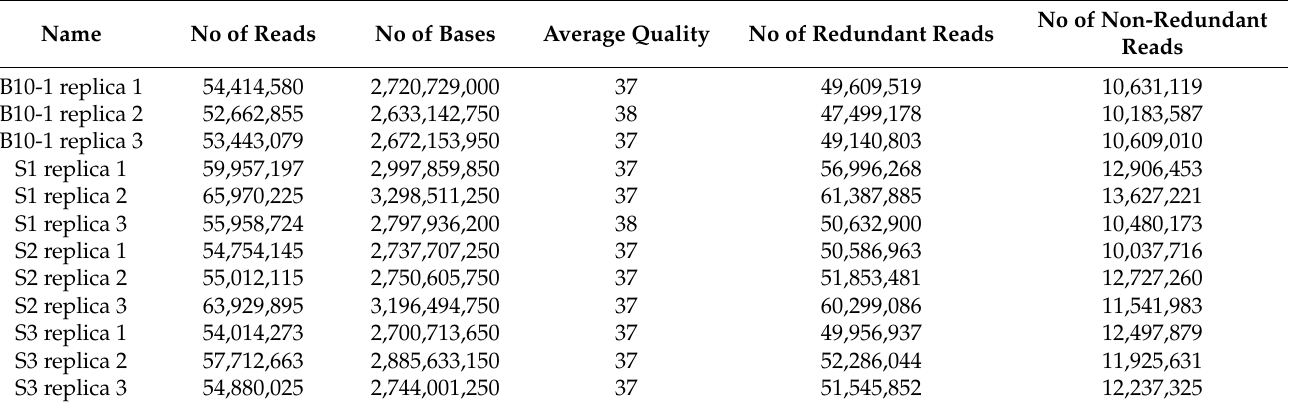
Table 1. Statistics of sRNA-sequencing analysis of three somaclonal lines (S1, S2 and S3) and control B10